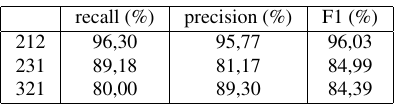
Table 5. Turkey: Evaluation metrics